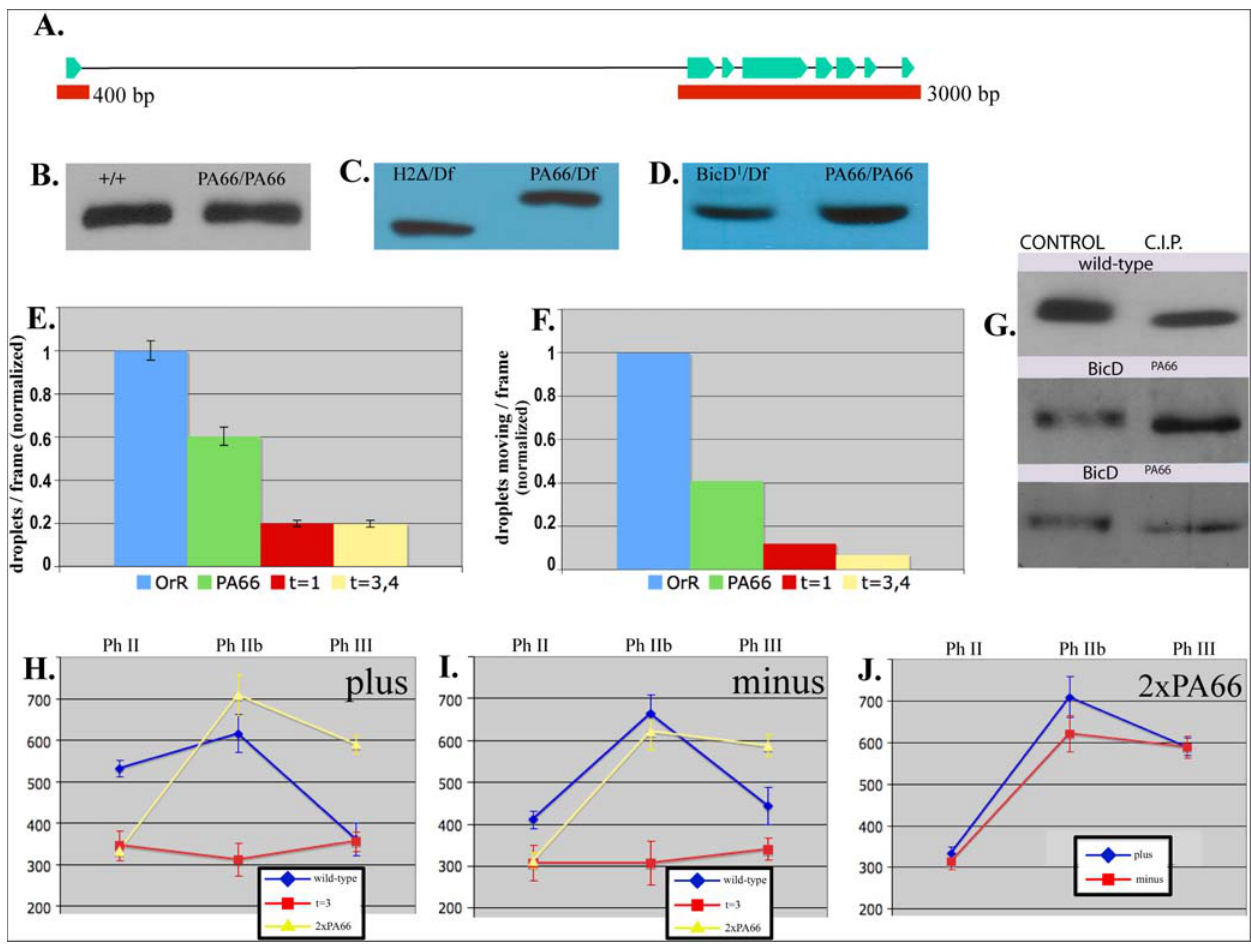
Figure 6. An analysis of the BicD PA66 allele’s failure to rescue. A: Sequence analysis of the BicD PA66 allele confirmed, as expected, that there was a single point mutation resulting in a single divergence (A40V) from the wild-type amino acid sequence. Light blue regions represent exons. Introns are represented by the intervening thin black lines. Red bars represent the two fragments upon which sequence analysis was carried out. B– D: BicD PA66 expression levels are similar to wild-type (B). BicD PA66 also showed similar expression to other alleles that were capable of rescue such as BicD 1 and BicD H2 D (C, D). Equivalent amounts of total embryo lysate were loaded per lane for each independent comparison (B–D). E: In phase II, BicD PA66 analysis identified a total number of droplets per frame intermediate between the wild-type and the null (‘t=1’, ‘t=3,4’) values. F: Also in phase II, the identified number of moving droplets in the BicD PA66 background was intermediate to the lower null values and the higher wild-type values. G: In the embryo, both BicD + and BicD PA66 appear to be phosphorylated as indicated by the resulting shift following phosphatase (C.I.P.) treatment. H–J: Particle tracking of BicD PA66 showed that phase II run lengths were identical to the BicD null (t=3) for both directions of transport (t- test, p . 0.75 for both directions) while phase IIb run lengths were similar to wild-type (t-test, p . 0.17) for both directions of transport (H, I). Phase III run lengths did not come back down from the phase IIb peak as seen in wild type. BicD PA66 displayed an inability to reverse the net direction of transport, while also displaying a slight bias for net plus-end directed transport